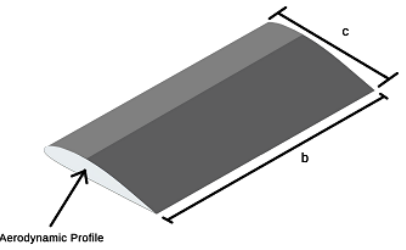
Figure 1. Main features of a rectangular wing.